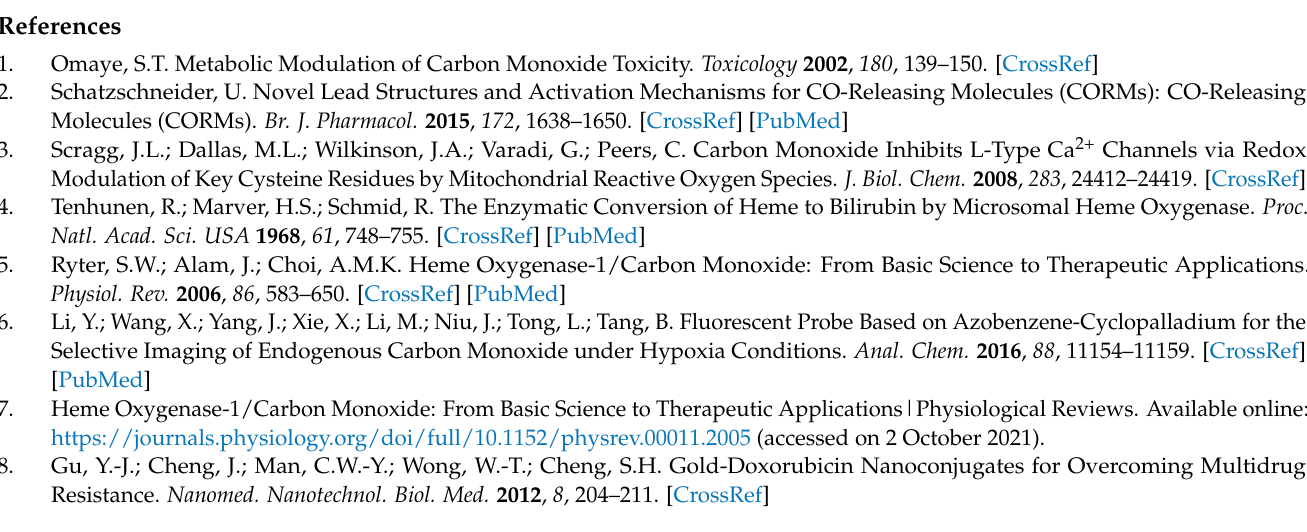
ether; Figure S2: 1 H-NMR and 13 C-NMR of TCF-ether; Figure S3. 1 H-NMR and 13 C-NMR of TCF-OH; Figure S4. 1 H-NMR and 13 C-NMR of TCF-ester; Figure S5. 1 H-NMR and 13 C-NMR of TCF; Figure S6. 1 H-NMR of DCI; Figure S7. 1 H-NMR and 13 C-NMR of DCI-OH; Figure S8. 1 H-NMR and 13 C-NMR of